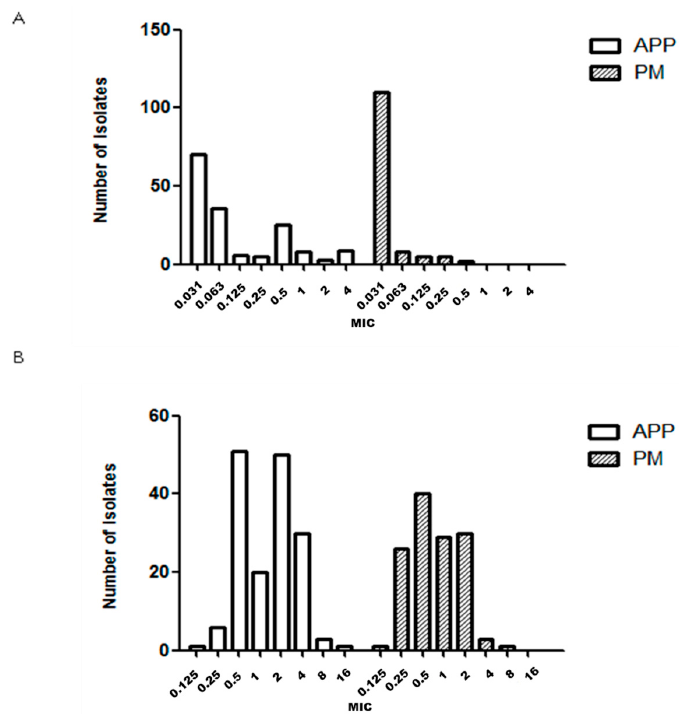
Figure 1. Minimum inhibitory concentration (MIC, μ g/mL) distribution of amoxicillin ( A ) and ceftiofur ( B ) for Actinobacillus pleuropneumoniae (APP) and Pasteurella multocida (PM) isolated from lungs of pigs with respiratory symptoms.